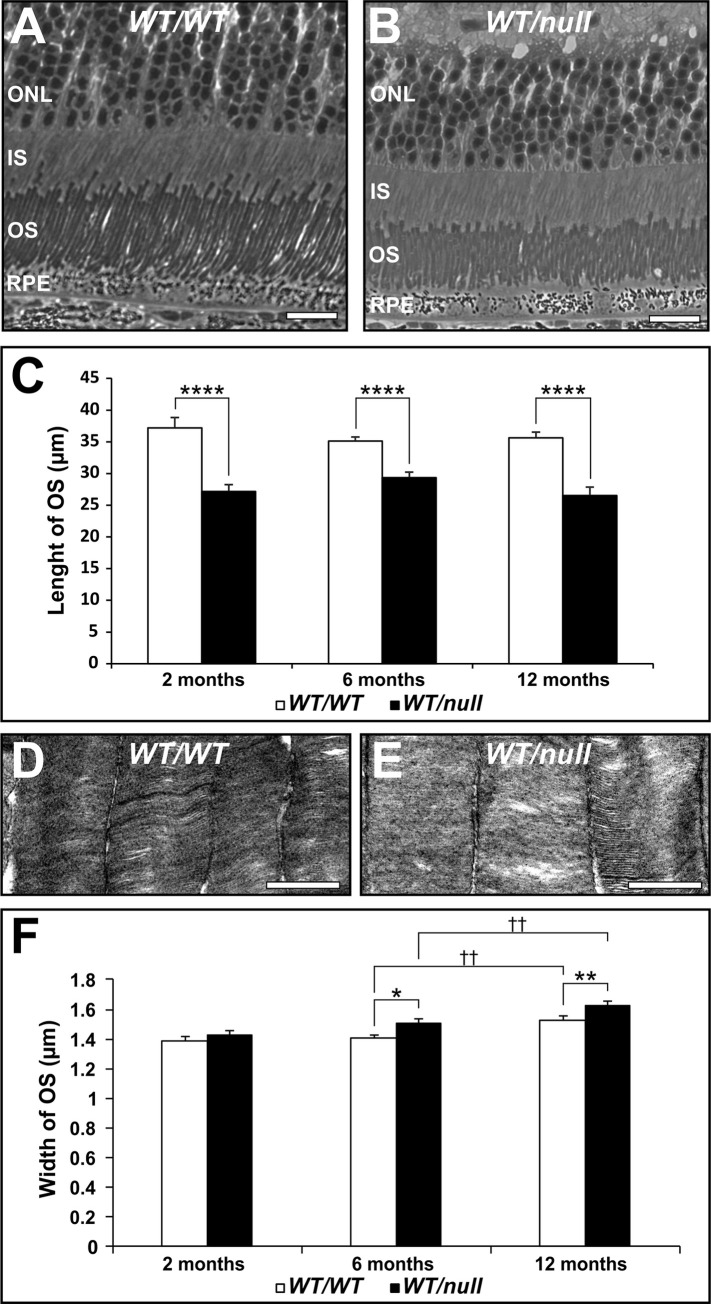
Chmnull/WT have uniformly shortened outer segments.Eyes from 2, 6 and 12 month-old heterozygous null female mice (Chmnull/WT) were processed for transmission electron microscopy. Low magnification examination of longitudinal sections throughout the length of the retina (from peripheral through central to peripheral), at 10 uniform intervals revealed uniform shortening of the OS (A-C). Higher magnification images revealed progressive increases in OS width (D-F). Scale bars: 20 μm (A,B), 1μm (D,E). T-test: ****p<0.001, n = 6 (C), *p<0.05, **p<0.01, †† p<0.01 n = 3 (F).